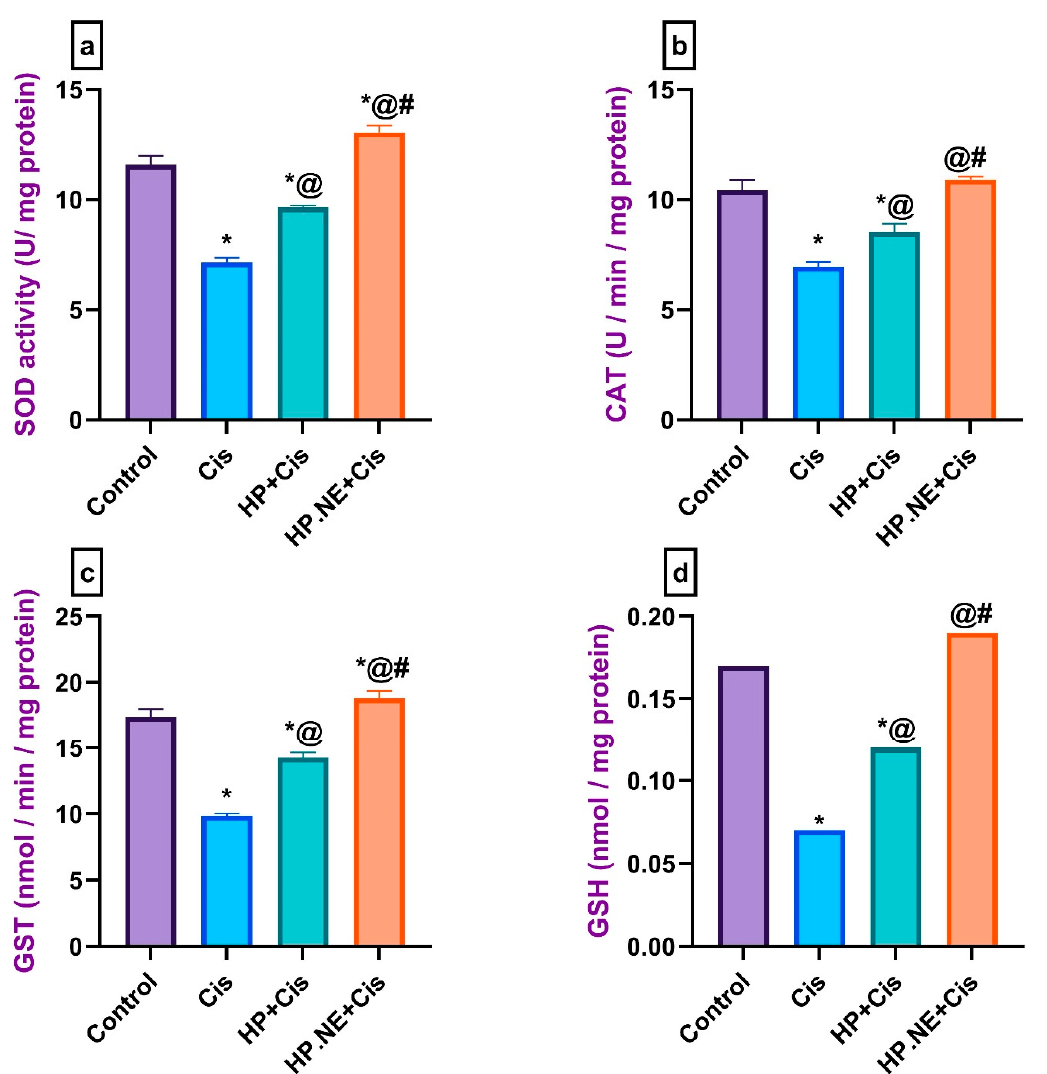
Figure 3. Effect of HP L. and HP.NE administration on the brain levels of oxidative biomarkers of different groups. ( a ) SOD: super oxide dismutase, ( b ) CAT: catalase, ( c ) GST: glutathione -s- transferase, and ( d ) GSH: reduced glutathione. Data are expressed as mean ± SE (one-way ANOVA) followed by Tukey’s post hoc test for seven rats in each group. * means significant from the Control group; @, significant from the Cis group, #, significant from the HP + Cis group.